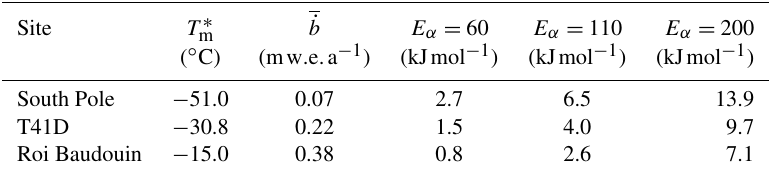
Table 2. E α − E H (kJmol − 1 ), revised from Table 2 of Morris and Wingham